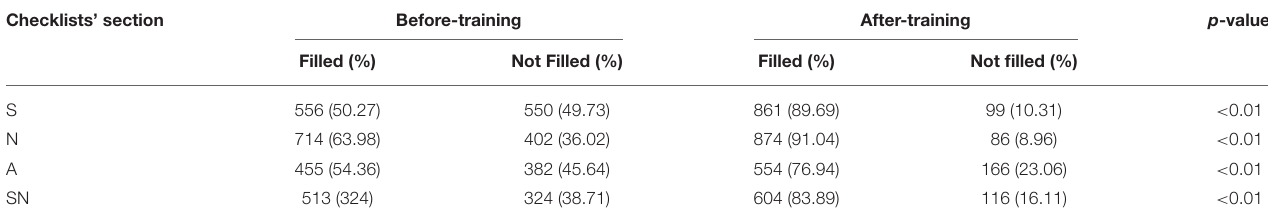
TABLE 2 | Incomplete checklist per